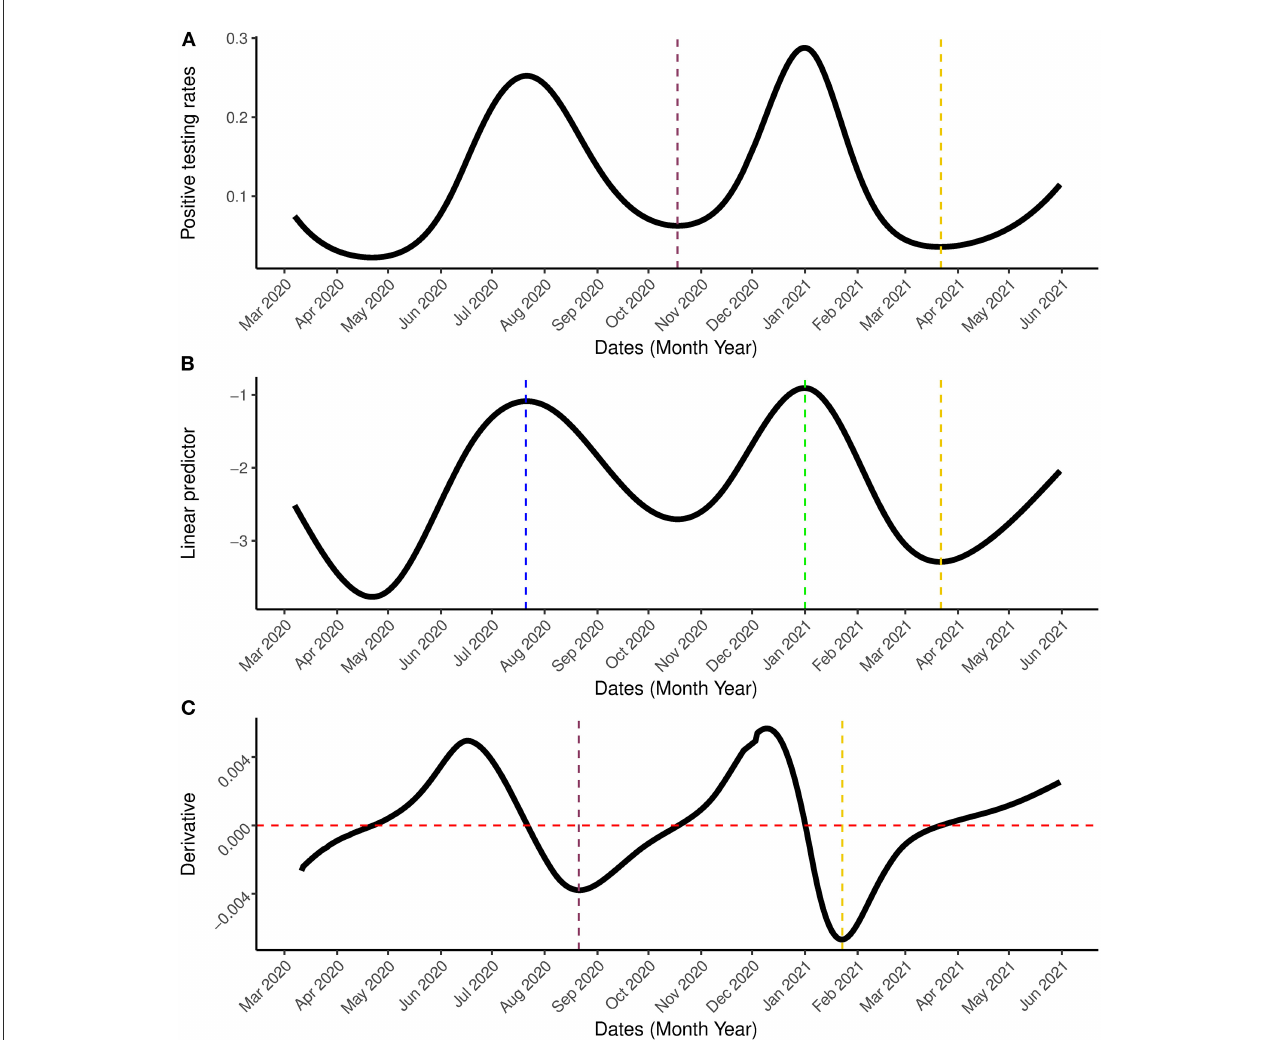
FIGURE7 Result incorporating the second wave. (A) Is the estimated positive testing rate with 95% simultaneous confidence band. (B) Is the linear predictor of the smoother with 95% simultaneous confidence band. (C) Is the first order derivative of the estimated probability with 95% simultaneous confidence band between March 7th, 2020 and May 31st, 2021. The blue and green vertical lines represents the peak periods while the pink and gold vertical lines are the turning points. In (C) , the gold line represents the date on which the rate of change started to increase (January 23rd, 2021) while the red horizontal line represent the rate of change at